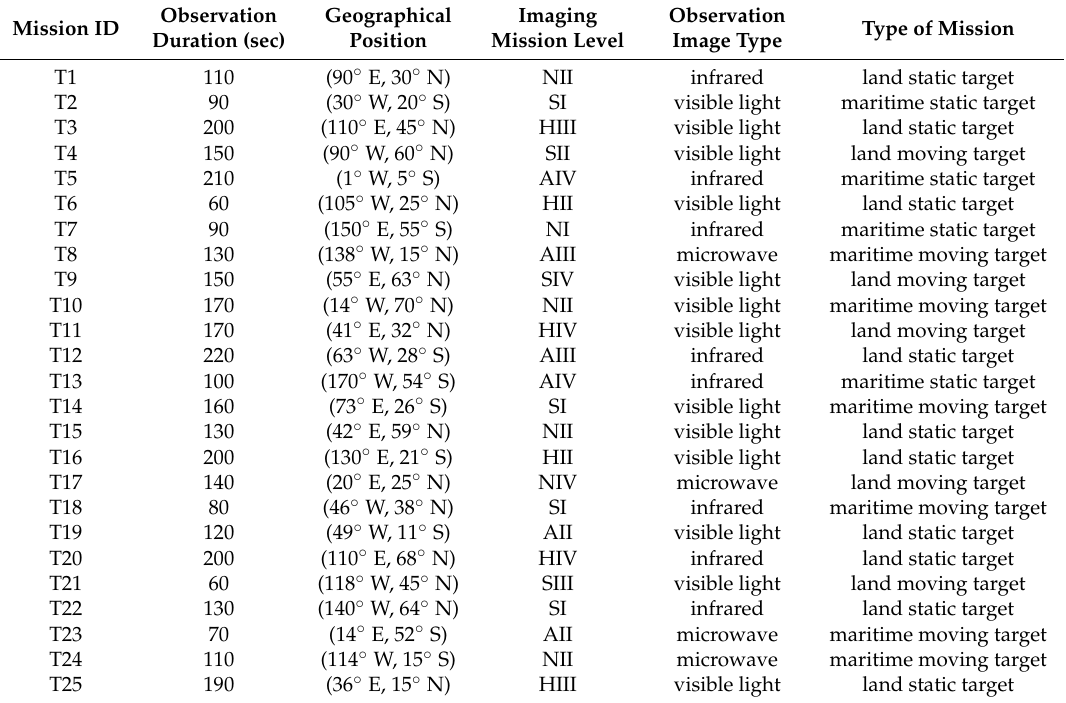
Table 5. Initial mission parameters.